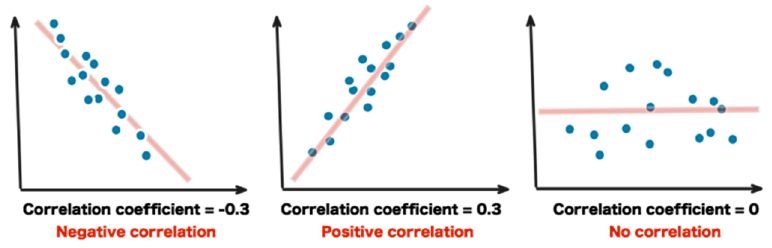
Figure 15. Example of correlation scores: −0.3, 0, and +0.3.